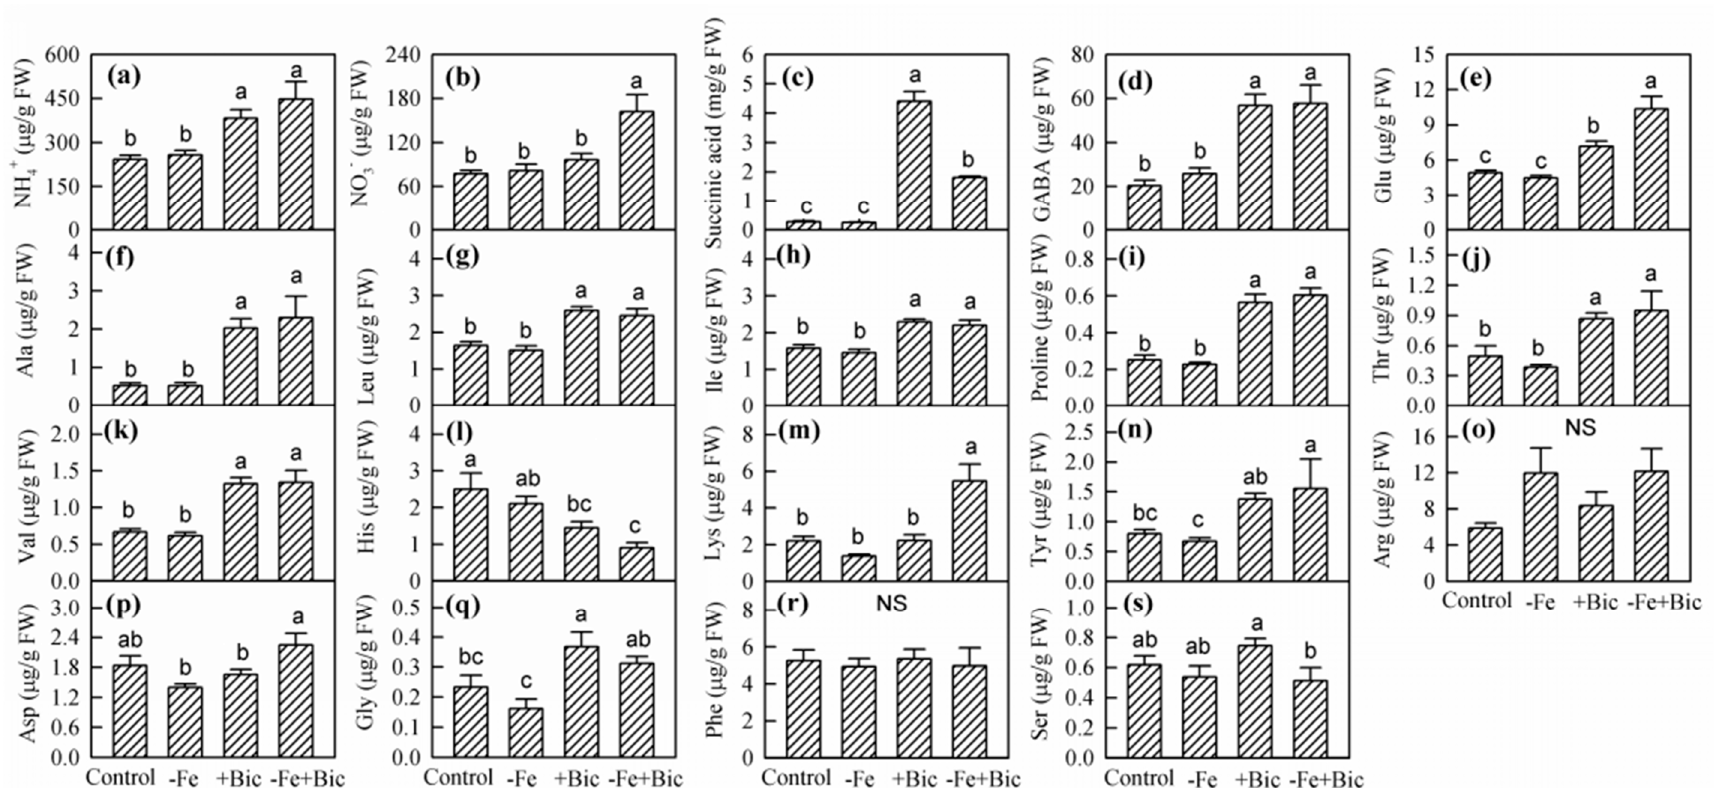
Figure 4. The concentrations of NH 4 + ( a ), NO 3- ( b ), succinic acid ( c ), and various amino acids ( d – s ) in roots of kiwifruit plants treated with -Fe, + Bic or -Fe + Bic in solution culture for 35 days. Values are means of five replicates ± SE. Different letters indicate significant differences among the treatments at P < 0.05. FW, fresh weight; NS, not significant. Ala, alanine; Arg, arginine; Asp, aspartic acid; GABA, γ -aminobutyric acid; Glu, glutamic acid; Gly, glycine; His, histidine; Ile, isoleucine; Leu, leucine; Lys, lysine; Phe, phenylalanine; Ser, serine; Thr, threonine; Tyr, tyrosine; Val, valine.